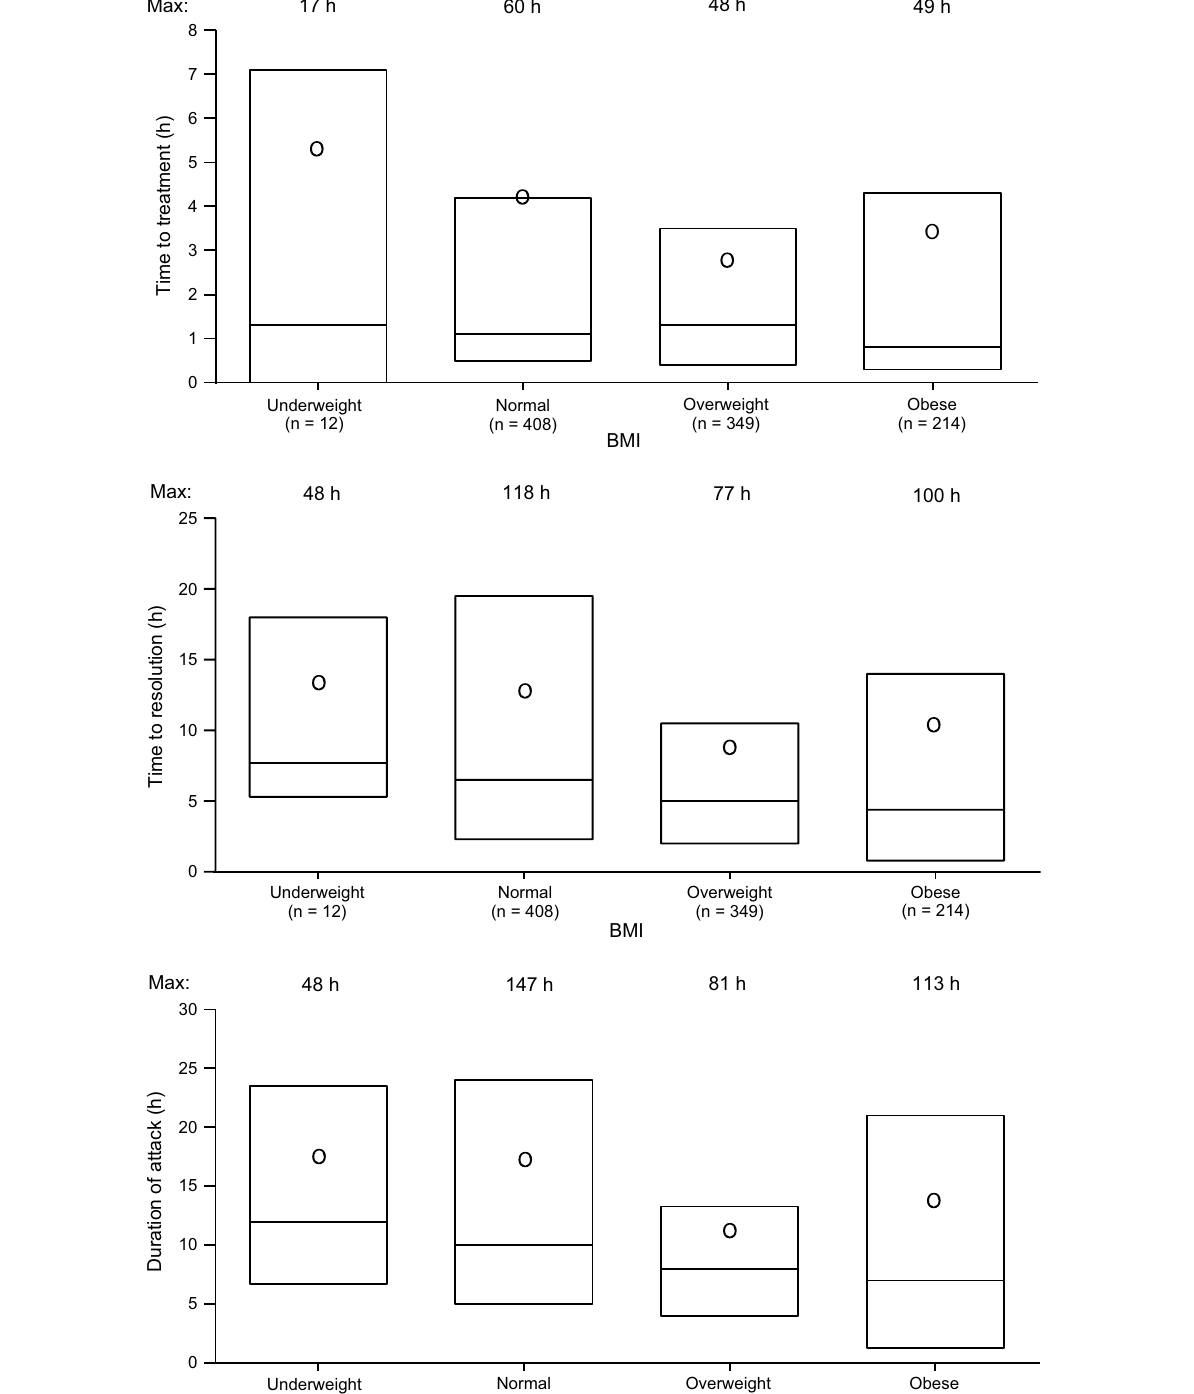
0.025 versus obese; time to resolu- =